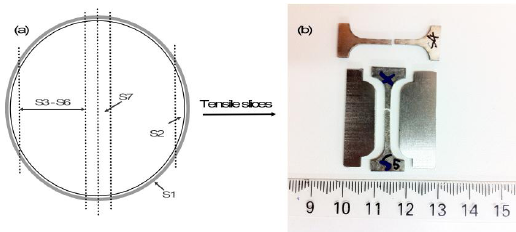
Figure 1. ( a ) Schematic illustration of the cylinder and the seven slices cut from the cylinder, only slices S3 to S7 were further machined for tensile test and ( b ) the tensile specimens after fracture. S1 was the outer scale, S2 to S7 were the slices cut from outer slice to the interior slices. S7 slices were cut from the central of the sintered large cylinder.